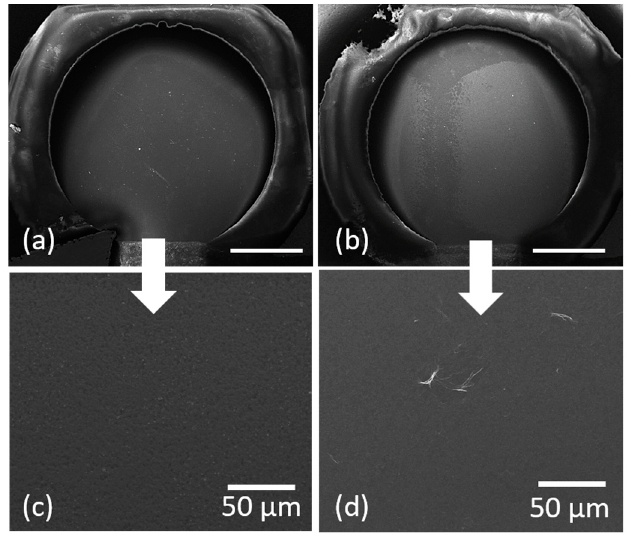
Figure 3. SEM images taken at different magnifications of the top surface of the working electrode ( a , c ) prior to LIFT; ( b , d ) after printing a 25:75 %wt. PEDOT:PSS: GO pixel at 600 mJ/cm 2 with a triazene polymer intermediate layer. The transfers are carried out at room temperature and in close contact between the donor and the receiver. The scale bar in Figure 3a,b is 1 mm.